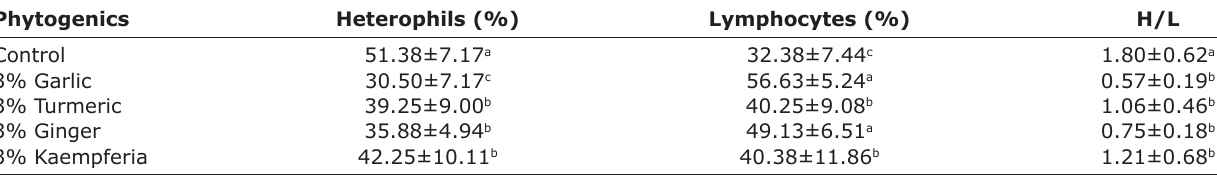
Table-5: Effect of phytogenics supplement on heterophils, lymphocytes, and H/L.